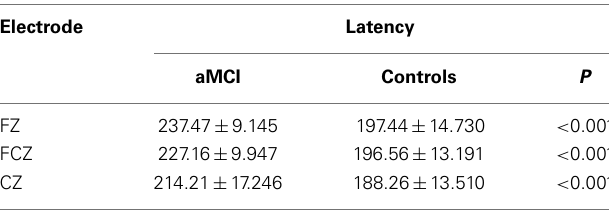
Table 3 | Comparison of MMN latency between aMCI and healthy controls